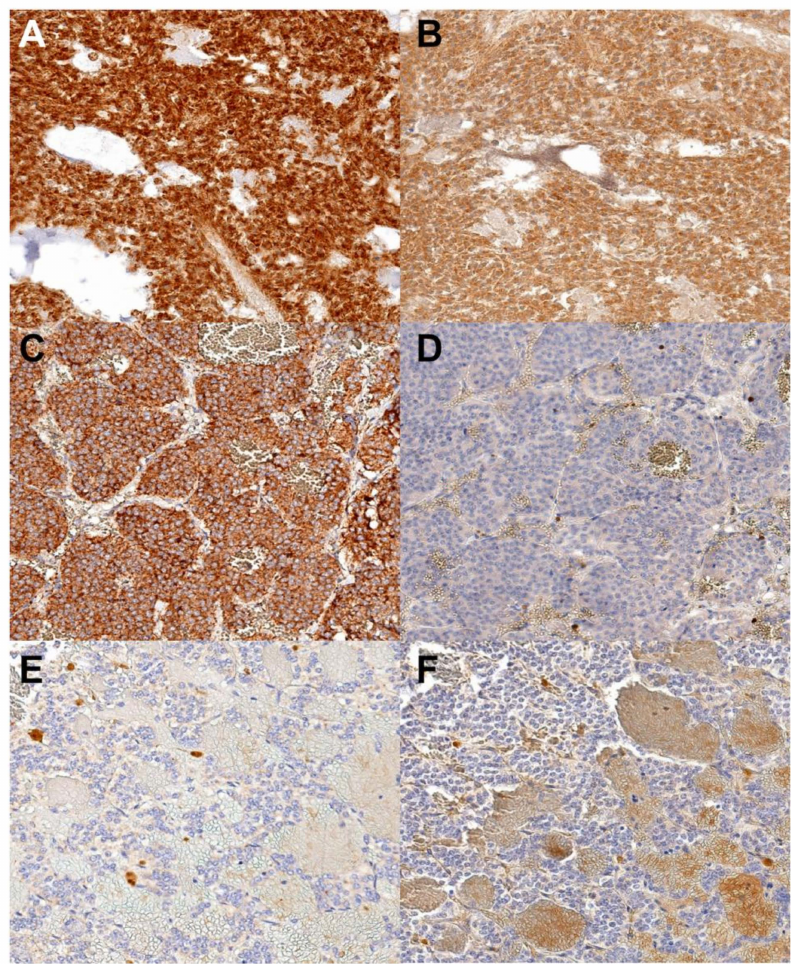
Figure3. SDHAandSDHBimmunoreactivity.( A , C , E )—SDHAimmunohistochemistry. ( B , D , F )—SDHB immunoreactivity. ( A ) and ( B ) represent a case with both SDHA and SDHB immunoreactivity; ( C ) and ( D ) have SDHA but lack SDHB immunoreactivity; ( E ) and ( F ) represent a case lacking both SDHA and SDHB immunoreactivity. SDHA—Succinate dehydrogenase A, SDHB—Succinate dehydrogenase B, Original objective 40 ×